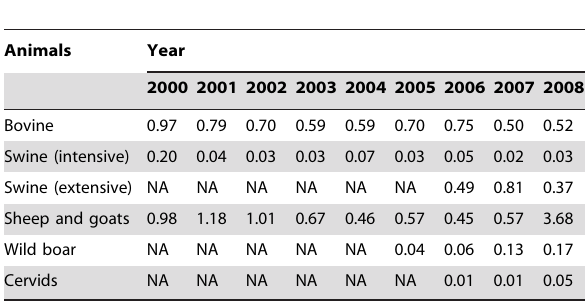
Table 1. Prevalence (%) of cystic echinococcosis in livestock and wild animals in Spain from 2000 to 2008.